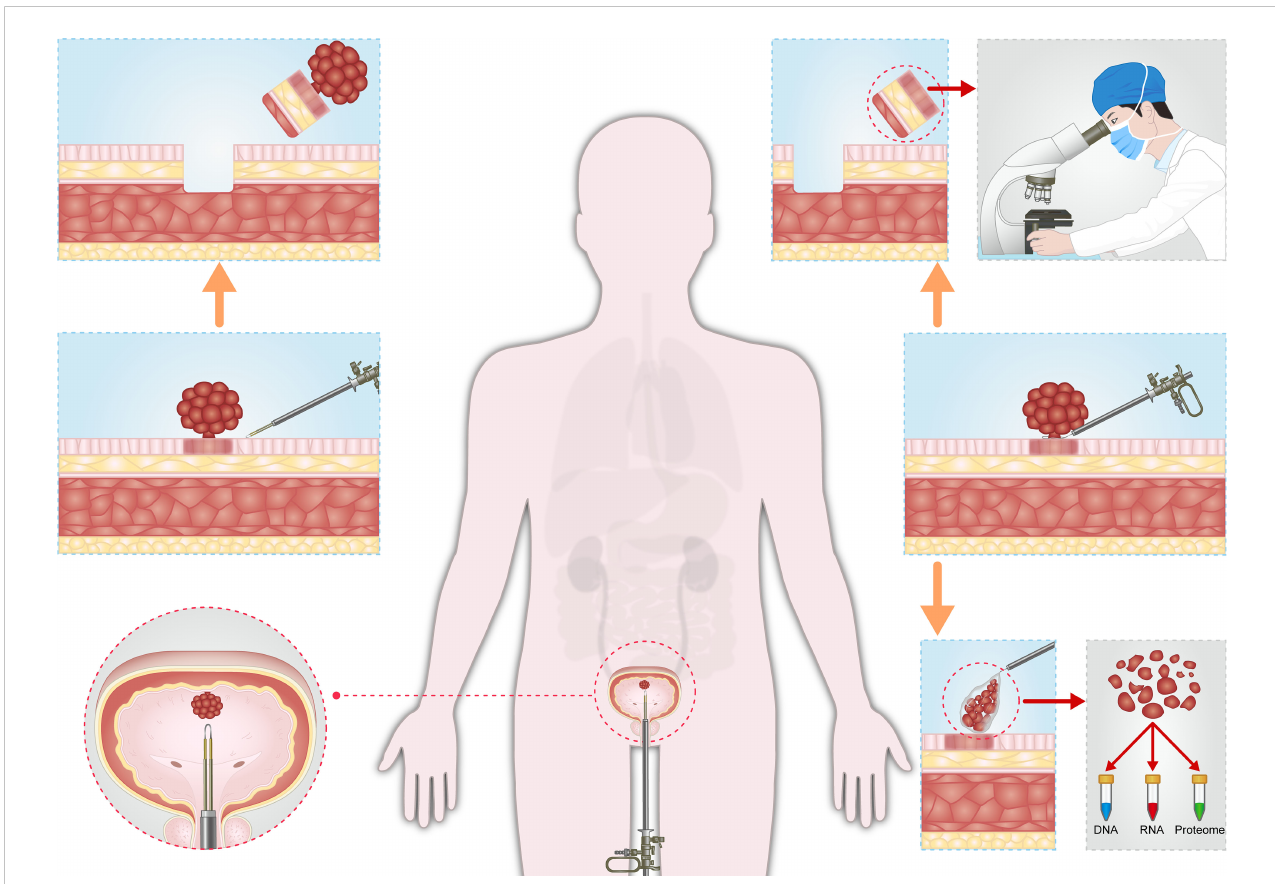
FIGURE 1 Schematic diagram of the precise diagnosis and treatment of NMIBC. ( Left ). For patients with suspected NMIBC, when the tumor diameter is less than 3cm, the whole tumor tissue is resected under the guidance of enhanced optical imaging. The urologist can completely remove tumor tissue under the guidance of enhanced optical imaging, and the pathologist can make accurate histopathological analysis after obtaining tumor samples. Complete transurethral tumor resection and accurate tumor risk strati fi cation are bene fi cial to reducing the risk of recurrence and progression after surgery. ( Right ). When the tumor was larger than 3 cm in diameter, the exophytic part of the tumor was fi rst removed in a whole piece, collected in an elastic bag and crushed into several pieces, and then taken out from the bladder for proteogenomics analysis. The tumor base containing DM was then en bloc resected for histopathological analysis. The whole tumor exophytic part collected in the elastic bag provides suf fi cient pathological specimens for proteogenomics analysis, while the tumor base containing DM facilitates histopathological analysis by pathologists, including T1 substaging, LVI, and histological